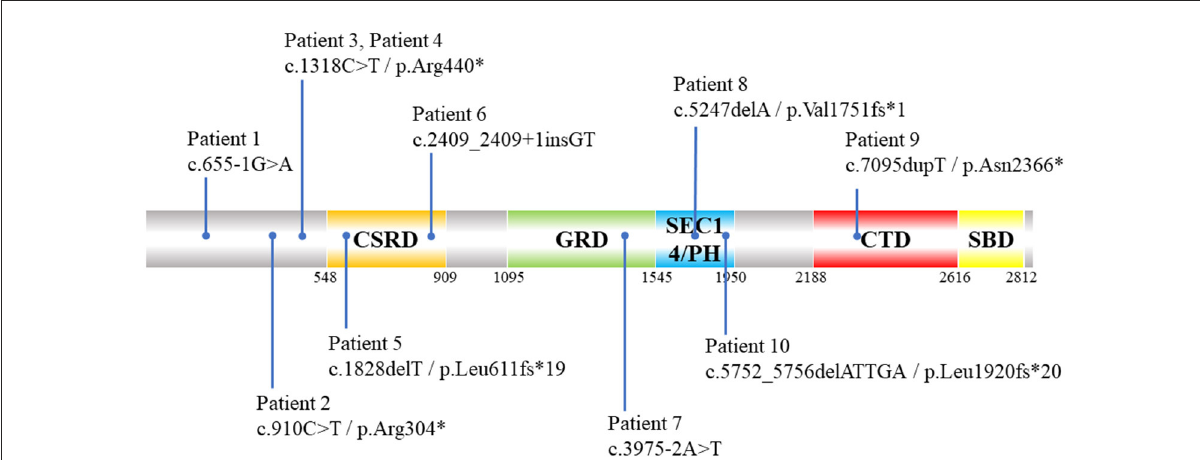
FIGURE2 Schematic diagram of distribution of 10 NF1 pathogenic SNVs and indels variants identified by ES in NF1 associated dystrophic scoliosis patients. CSRD, Cysteine-Serine-rich domain; GRD, GTPase-activating protein-related domain; SEC14/PH, SEC14 domain and pleckstrin homology